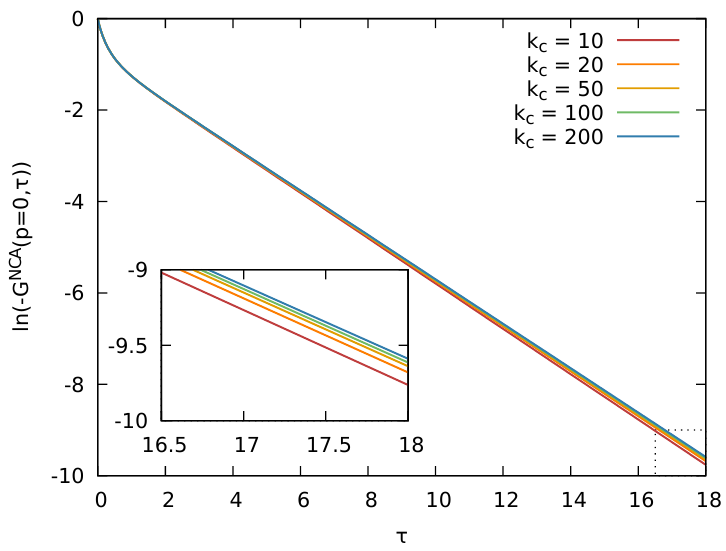
Figure 21: Dependence on the momentum cutoff for the NCA propagator. In each case, the maximum of 19 iterations has been used to ensure convergence. The inset shows a zoomed view of the same data at late